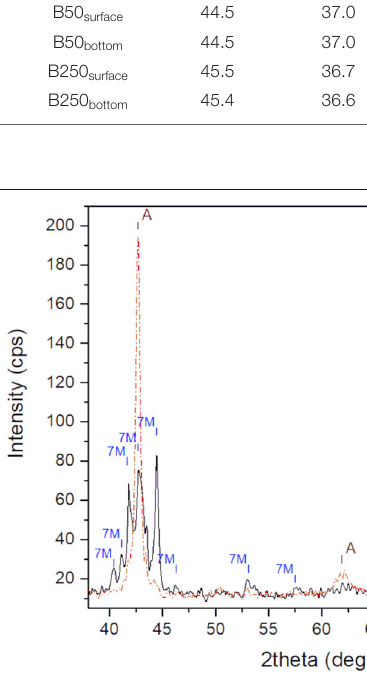
TABLE 3 | Summary of the average, surface, and bottom chemical compositons for the A50, B50, and B250 samples. at% Ni at% Mn at% In at% Co at% Ni at% Mn at% In at% Co Target